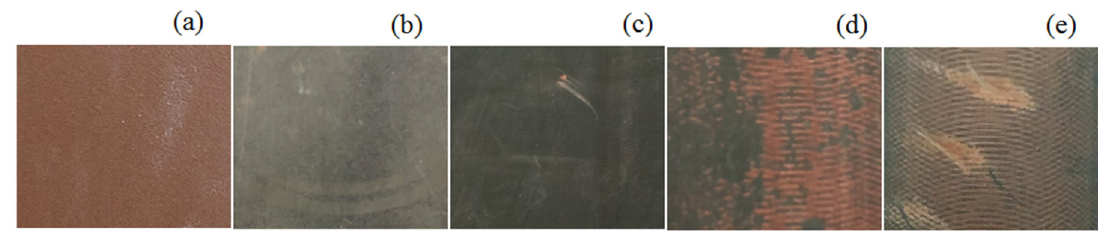
Figure 18. Surface condition under various travelling speeds ( a ) initial state; ( b ) 1.5 m/min; ( c ) 2.25 m/min; ( d ) 3 m/min; ( e ) 3.75 m/min.